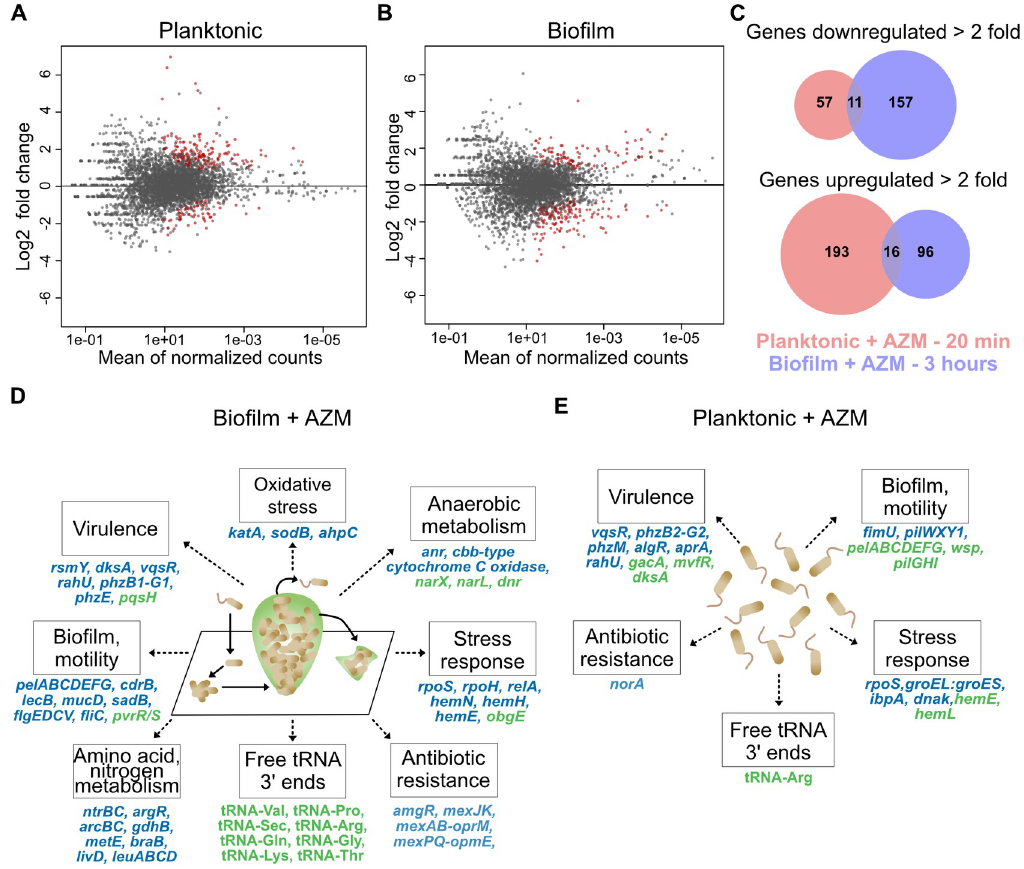
Fig 2. AZM alters full length transcript synthesis of P . aeruginosa genes. (A and B) Scatter plot of DEseq2 analysis of expression changes in PA14 planktonic cultures and biofilms treated with AZM. Red dots indicate DEseq changes at 10% FDR. (C) Genes showing > 2 fold down (top) or up (bottom) differential regulation upon AZM treatment. AZM induced regulation of planktonic and biofilm genes, indicated in red and blue, respectively, show little overlap. Key PA14 genes regulated by AZM in biofilm (D) cultures and planktonic (E) cultures. Downregulated genes are colored blue, whereas upregulated genes are colored green. Many of these genes have pleiotropic functions, thus impact additional cell processes beyond the primary category in which they are shown